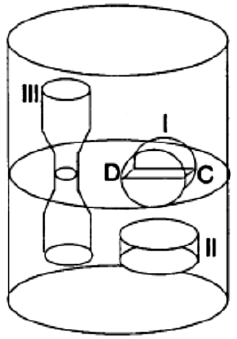
Figure 2. Tensile and diametral compression sample.